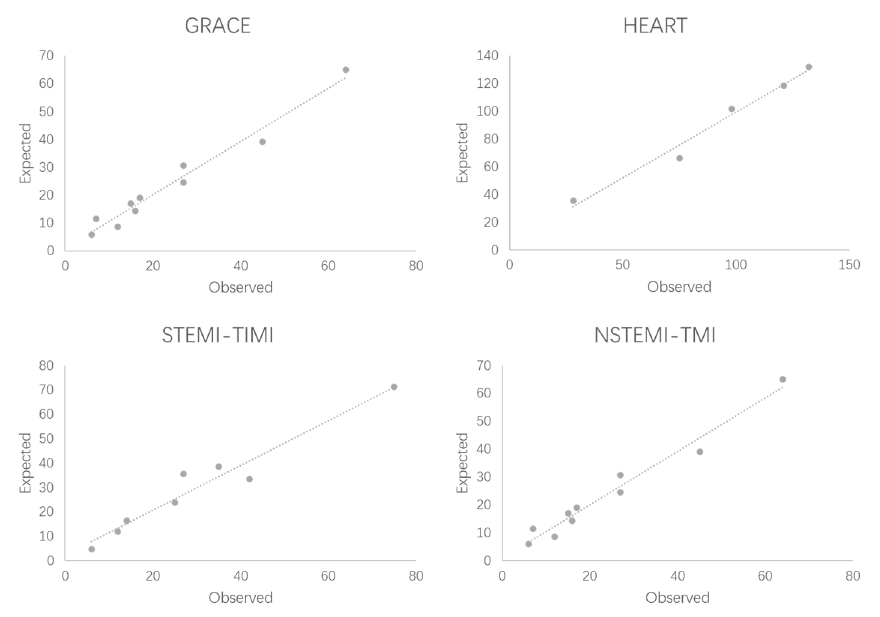
Figure 5. Hosmer–Lemeshow test for risk